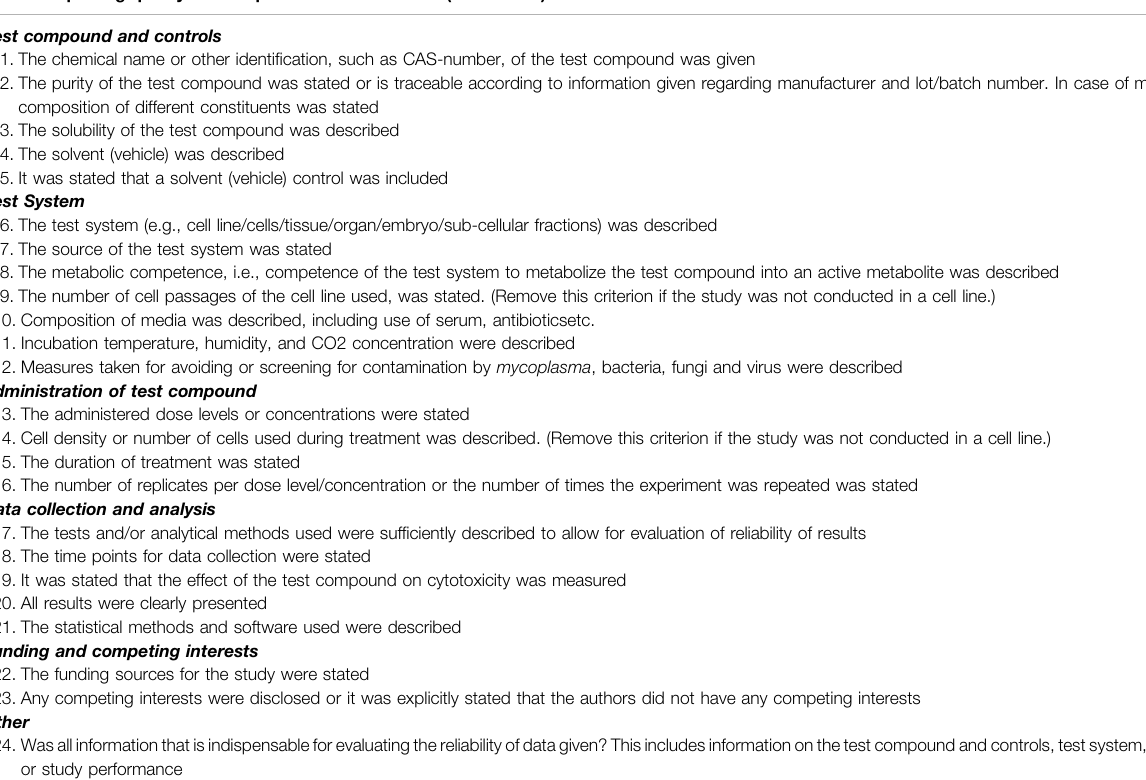
TABLE 1 | SciRAP criteria for assessing reporting quality of in vitro toxicity studies (version 2.0). SciRAP reporting quality criteria per evaluation domain (version